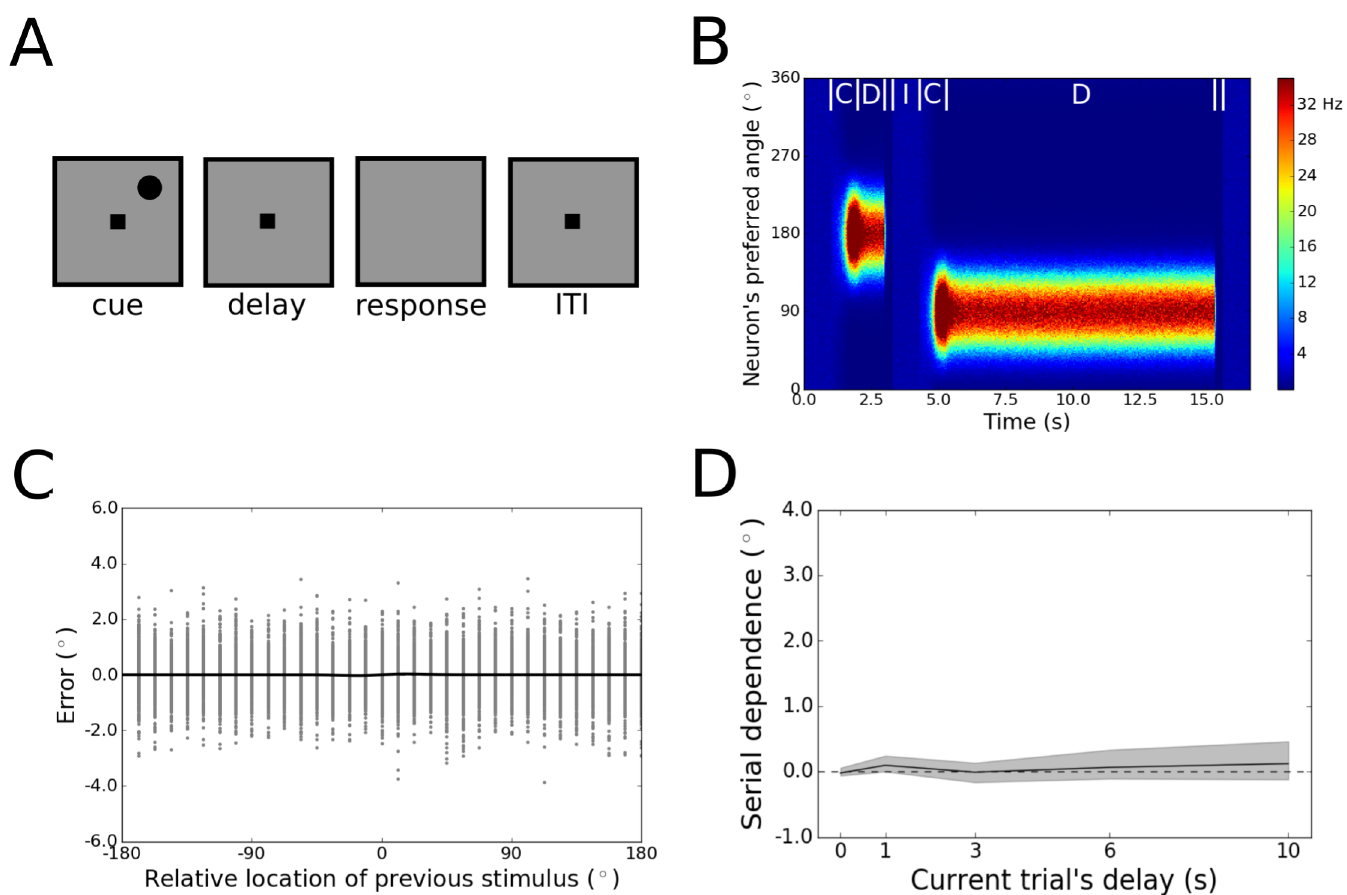
Fig 1. Results for Model 1. (A) The events in each trial of the workingmemory task used to test Models 1-3. Each trial started with the presentationof a cue whose angle from fixation was varied. Cue presentation was instantiated as an injectionof current into the neurons, with the magnitudeof the current set as a Gaussian function of the difference betweenthe stimulus feature value and each neuron’spreferredlocation. The first cue in each pair of trials was presentedat 180˚. One of 32 angles evenly spaced around360˚ was chosen for the second stimulus. The cue was maintainedin the network across a delay period(without continuedstimulus-driven current injection).Finally, the removalof the fixation square from the screen signaledthe start of the response period, when the network’s responsewas decodedand activity was reset via the passageof unstructured inhibitorycurrent into the network. An ITI separatedeach responseperiod from the subsequent cue period. (B) Activity in the network, with neuronslined up along the y-axis accordingto the stimulus angle to which they respondmost strongly. Firing rates are color-coded. Two trials are shown with different delay lengths, the first with the stimulus at 180˚ and the second with the stimulus at 90˚. At the start of each trial, during the cue period(labeledC in the figure), a bump of activity forms in the network, centered at the stimulus location.This bump weakensslightly duringthe transition to the memory delay period (labeledD), but is maintained throughoutthe delay. The bump is reset at the end of each delay, when the responseis made. After the response, the ITI (labeledI) begins. (C) Tuningof serial dependence across all angulardifferencesbetween the current and previousstimulus. Raw errors for every simulationare in gray, and the best fit of the derivative of Gaussian (DoG) function used to model serial dependence is in black. No serial dependence is apparentin the responses—error is distributed evenly around a horizontalline at 0˚. (D) Peak-to-peak of the DoG function across the workingmemory delay. Shadingdepicts bootstrapped 95% confidenceintervals. There is no evidenceof serial dependence regardlessof the durationfor which the network maintainsthe current trial’s stimulus feature.